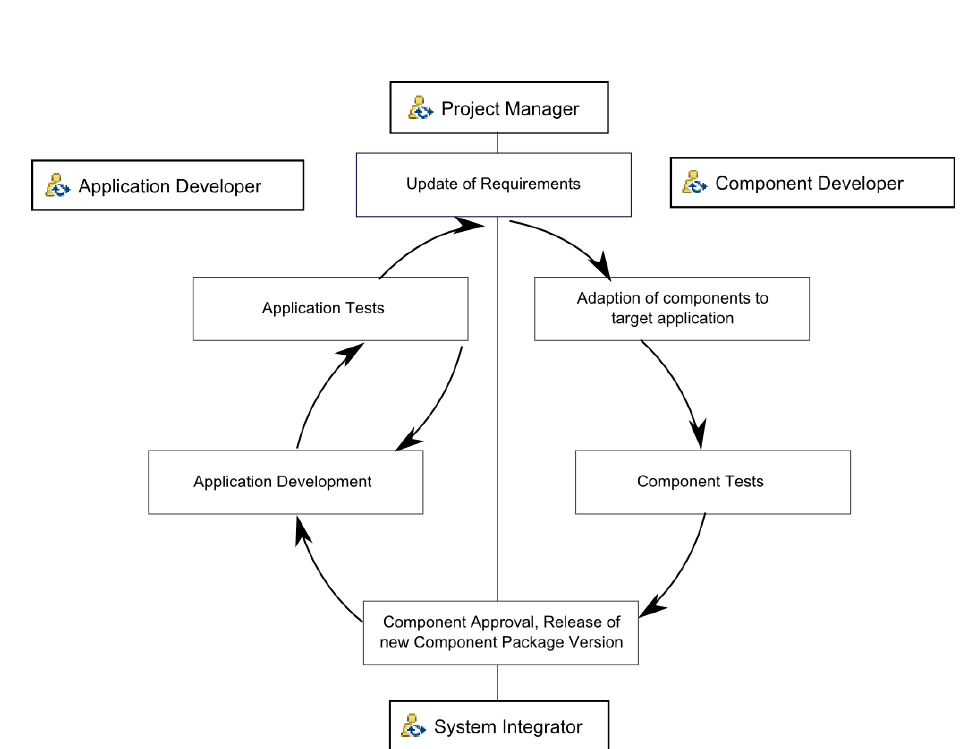
Figure 11. Schematic view of the distributed integration process. Component Development is separated from application development. Component packages are released on a regular